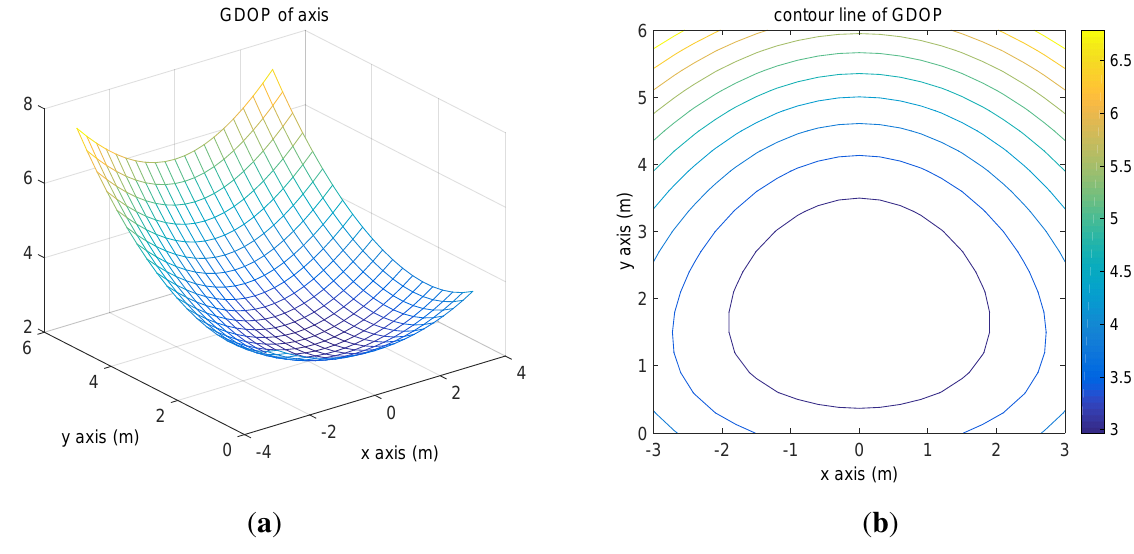
Figure 6. Geometric dilution precision (GDOP) distribution. ( a ) GDOP of the axis; ( b ) contour line of